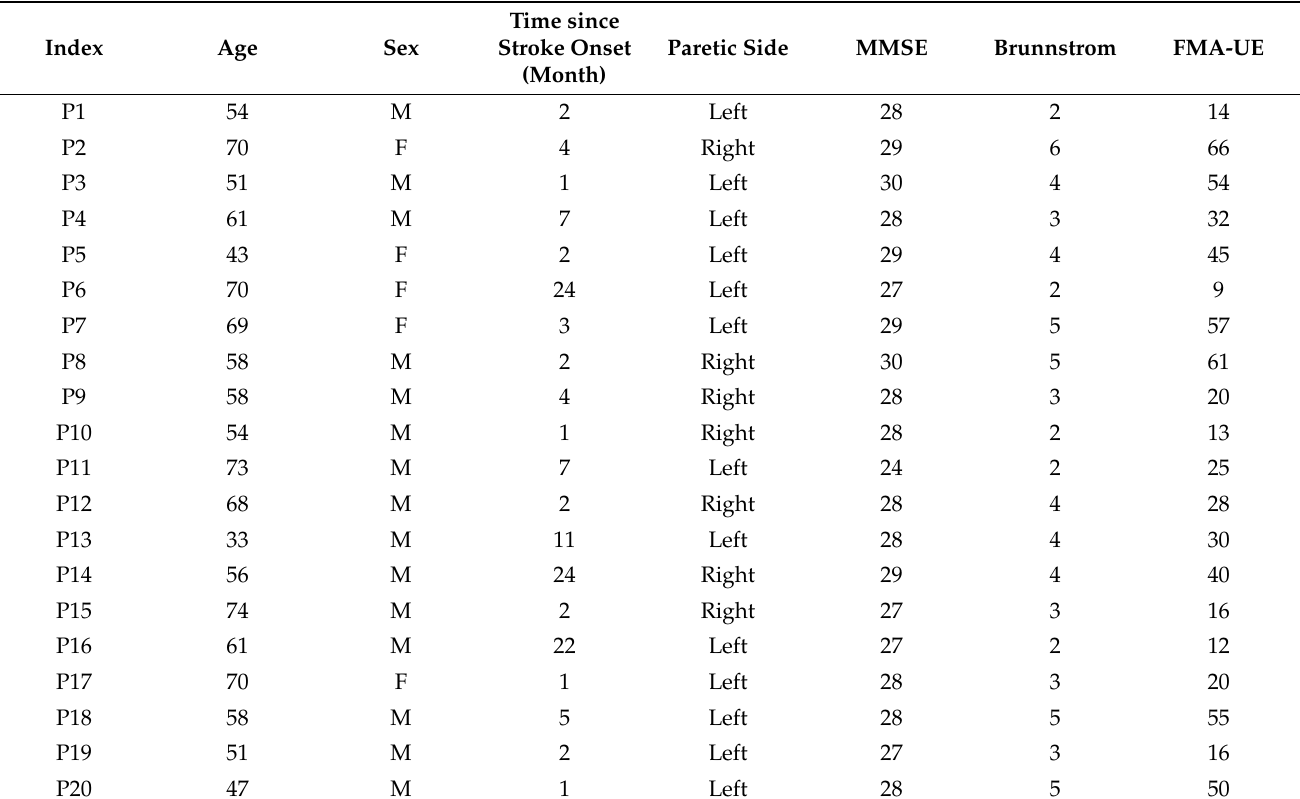
Table 4. Characteristics of Stroke Subjects.